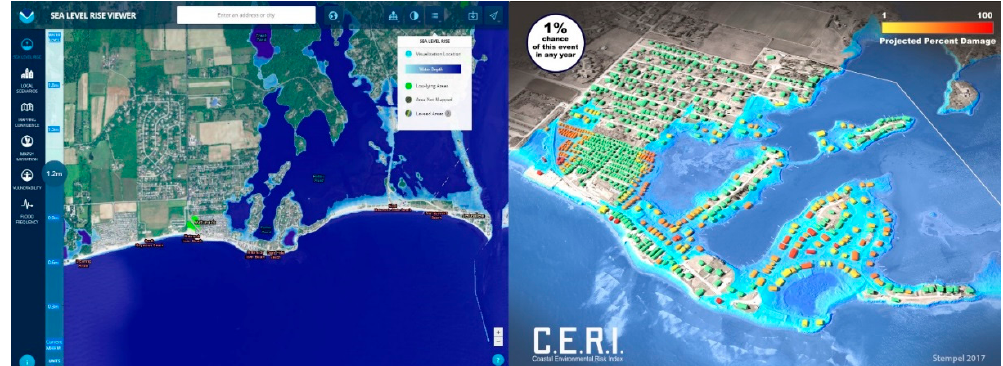
Figure 5. Comparison of map based NOAA Sea Level Rise Viewer and Semi-realistic 3D model output based on the Coastal and Environmental Risk Index (CERI) demonstrating the distinction between them. Both depict Matunuck, RI, USA [6,44] . Image left: NOAA. Image right: Authors. Norms for scientific visualization emphasize the clear, nondramatic presentation of data.